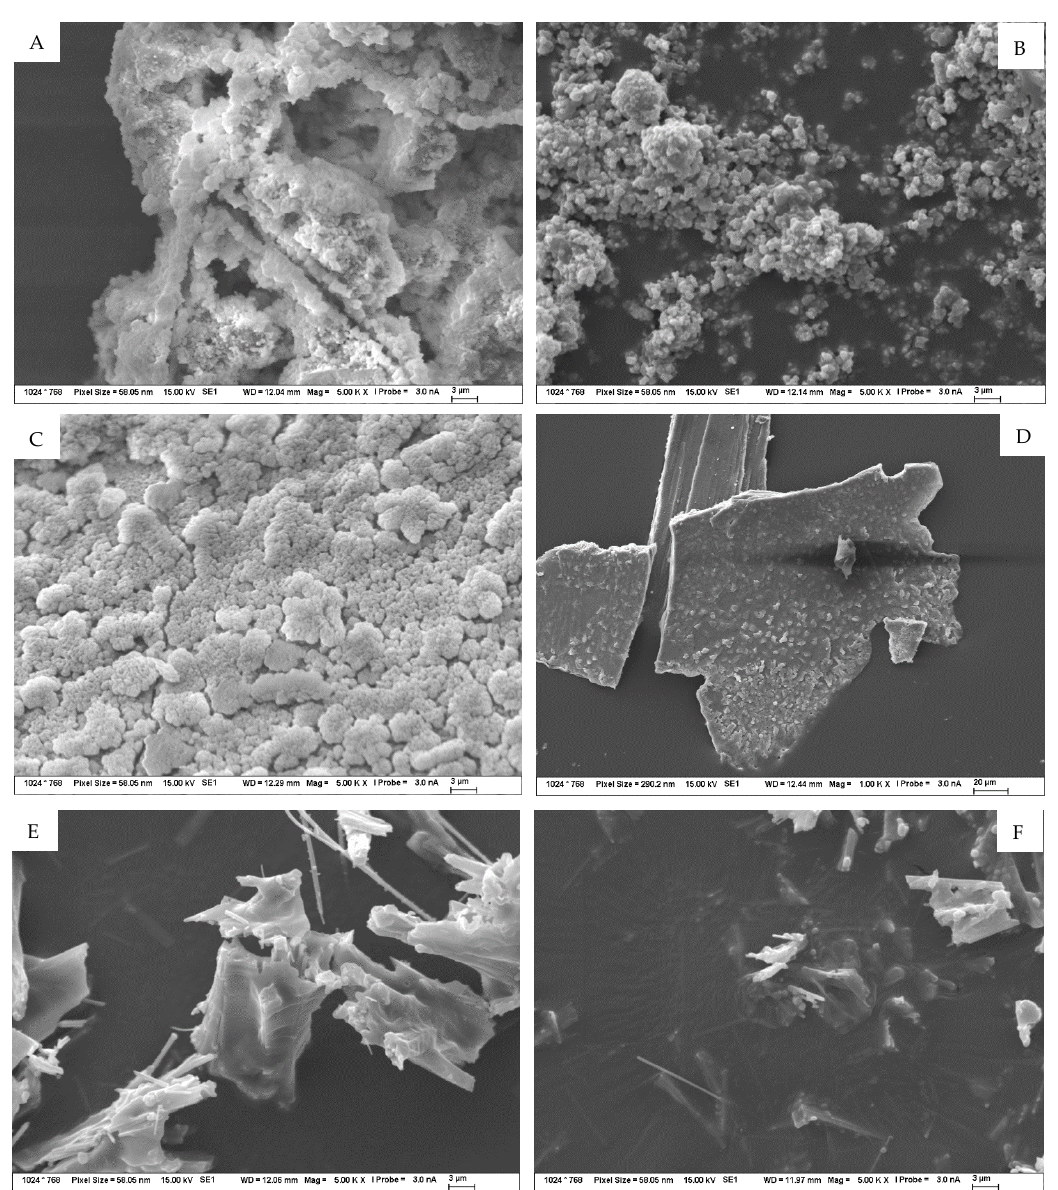
Figure 13. ( A–F ) Detailed SEM images of the products formed on the TS surface as a result of exposure to 1 mol/L solutions at 40 °C for 120 days. Fig. A and B symbolize structure of TS exposed to carbonate solution; C and D exposed to hydroxides and E and F exposure to nitrates.